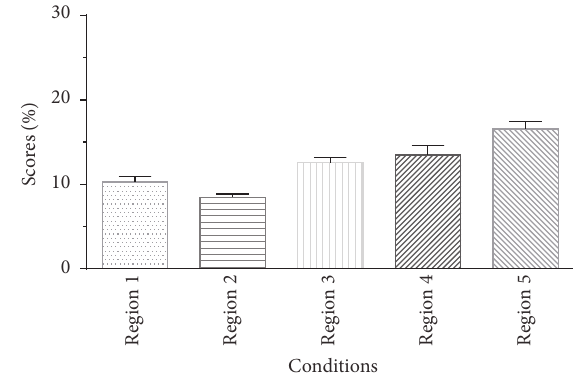
Figure 1: Averaged percent-correct scores for sentence recognition using acoustic temporal envelope as a function of condition in Group 1. The error bars indicate standard